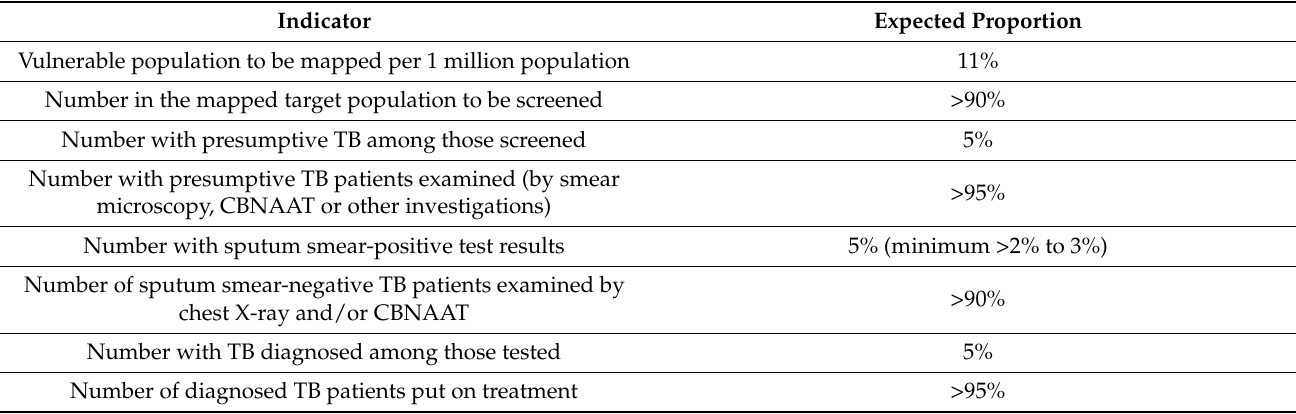
Table 1. Expected indicators for the active case finding (ACF) campaign in the National Tuberculosis Elimination Programme *. Indicator Expected Proportion Vulnerable population to be mapped per 1 million population 11% Number in the mapped target population to be screened >90% Number with presumptive TB among those screened 5% Number with presumptive TB patients examined (by smear microscopy, CBNAAT or other investigations) Number with sputum smear-positive test results Number of sputum smear-negative TB patients examined by chest X-ray and/or CBNAAT Number with TB diagnosed among those tested